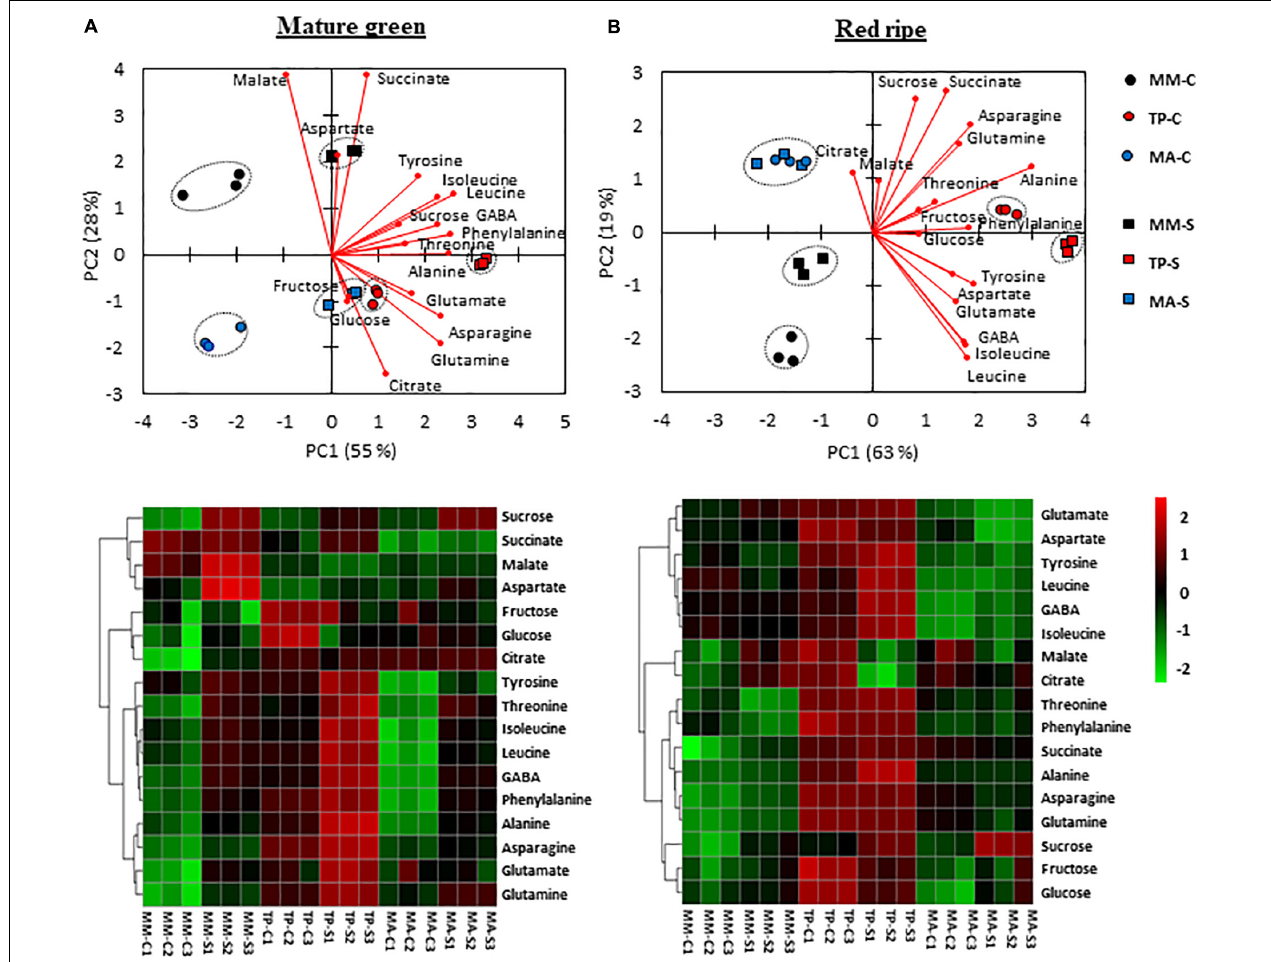
FIGURE 5 | Changes in the profile of primary metabolites (sugars, organic acids, and amino acids) in mature green and red ripe fruits of “Moneymaker” (MM) and two traditional varieties, “Tomate Pimiento” (TP) and “Muchamiel Aperado” (MA), from plants grown in control (C) and salt (50 mM NaCl) (S). Non-supervised principal component analysis (PCA biplot) (top graphics) and heatmap analysis (bottom graphics) representing the major sources of variability in mature green (A) and red ripe fruits (B) . Color scale represents the variation in the relative concentration of compounds, from high (red) to low (green)